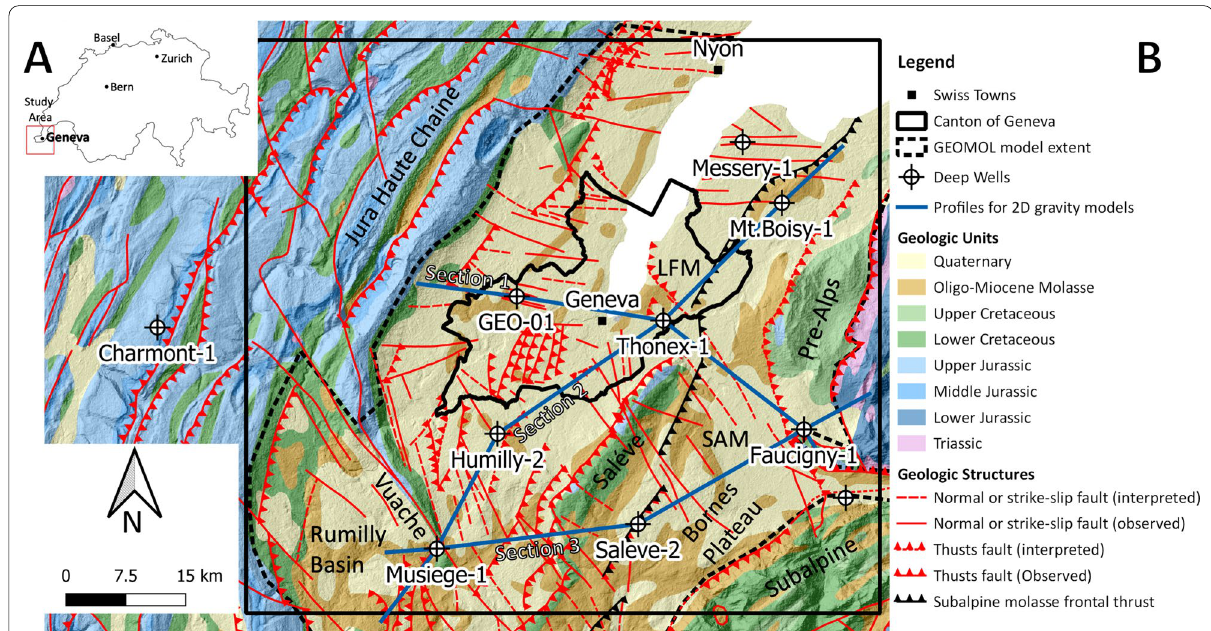
Fig. 1 A Map of Switzerland with location of the study area; B Geological map over the Geneva Basin with an indication of the main deep wells ( modified from Brentini, (2018); Clerc & Moscariello, (2020); Moscariello et al. (2014))